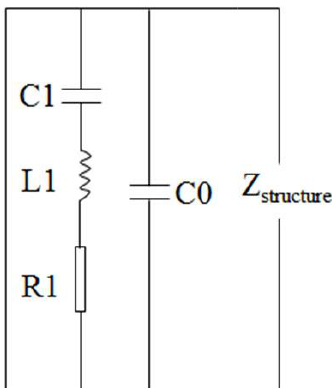
Figure 5. Equivalent circuit of piezoelectric materials around the resonant frequency. C 0 : the parallel capacitance; R 1 : dynamic electric resistivity; C 1 : dynamic electric capacitance; L 1 : dynamic electric inductance